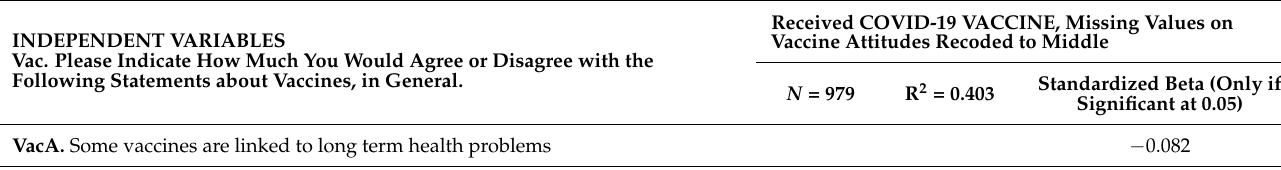
Table 4. Predicting COVID-19 Vaccines Received by General Beliefs toward vaccines (unweighted).